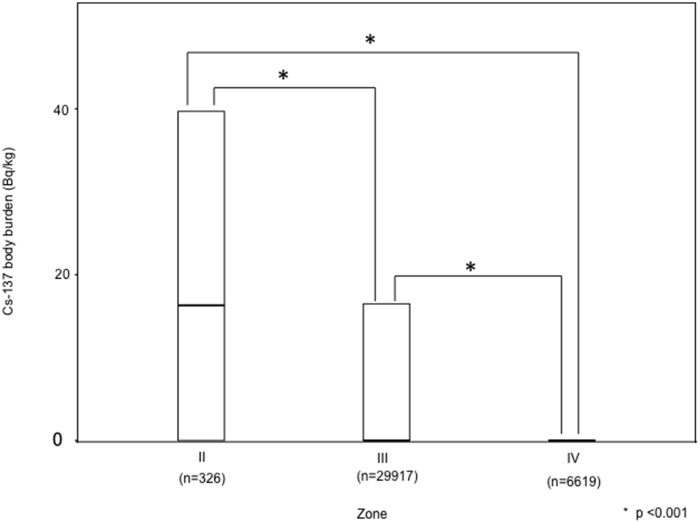
Cs-137 body burden in the residents living in each zone.The end of the box indicate the positions of the 75th percentiles of the data. The Cs-137 body burden was significantly higher in more contaminated zone.